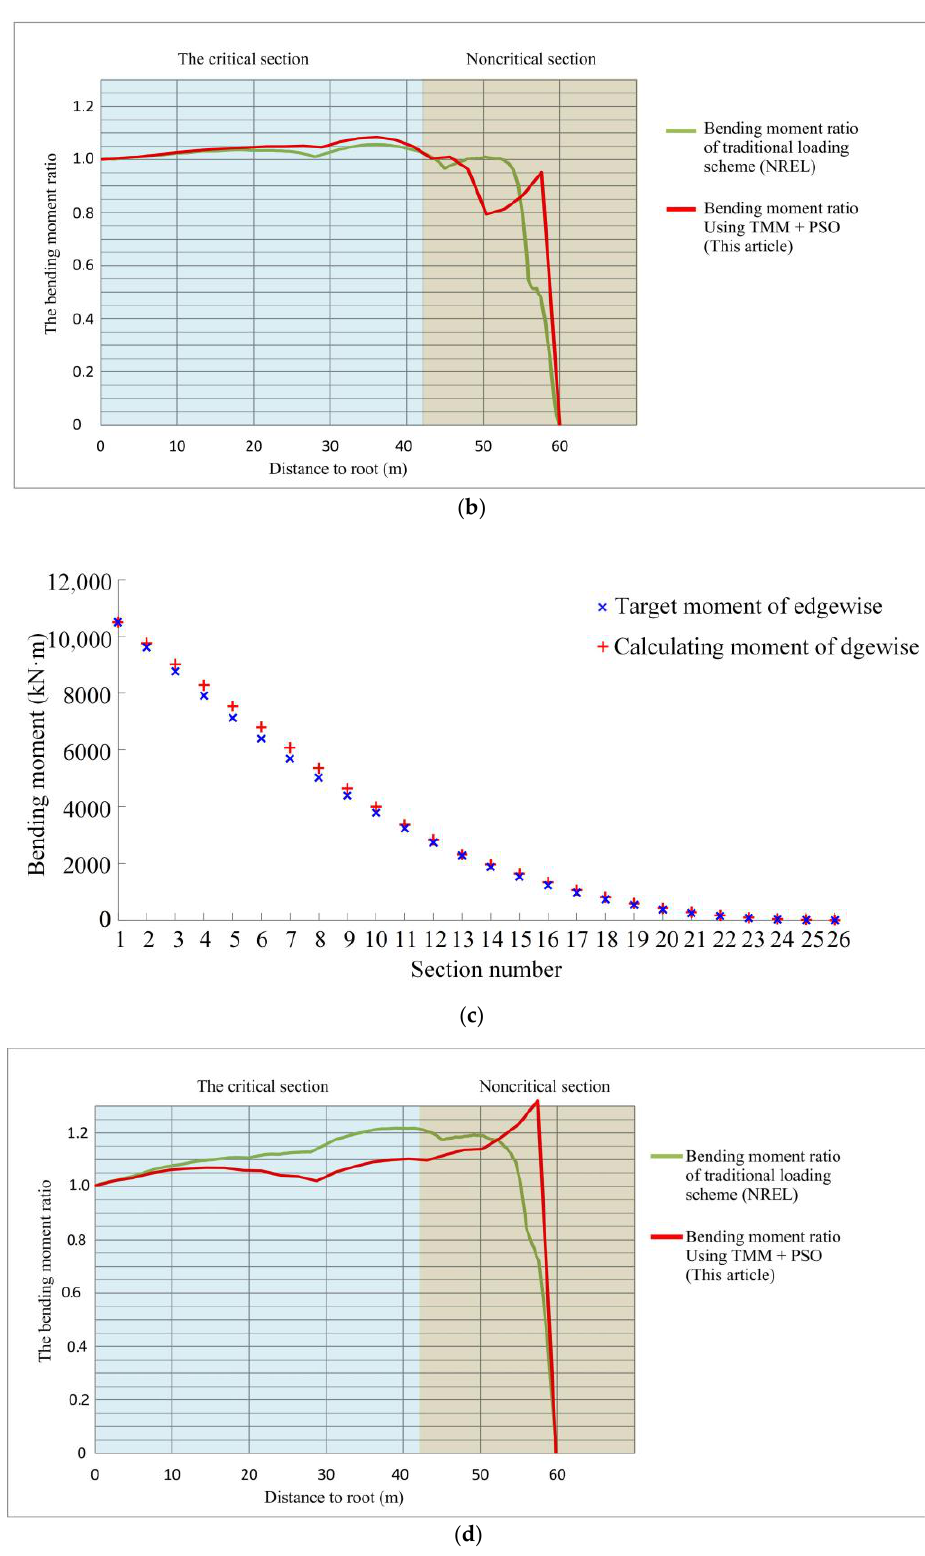
Figure 31. Comparison between optimization result and target bending moment. ( a ) flap-wise bending moment distribution; ( b ) Ratio of predicted bending moment to target bending moment in flap-wise; ( c ) edgewise bending moment distribution; ( d ) Ratio of predicted bending moment to target bending moment in edgewise .